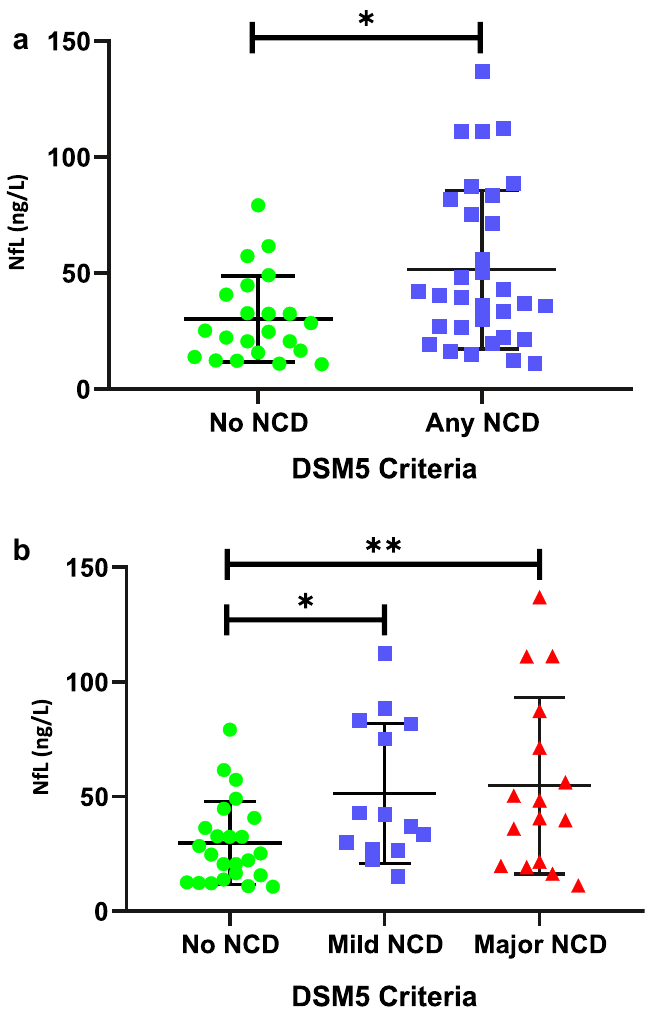
Figure 1. Histograms showing plasma NfL levels for participants based on DSM 5 NCD criteria, with mean and standard deviations. ( a ) Shows the distribution of individuals categorised as no NCD compared to those with either mild or major NCD. ( b ) Shows the distribution of NfL comparing those with no NCD, mild NCD and major